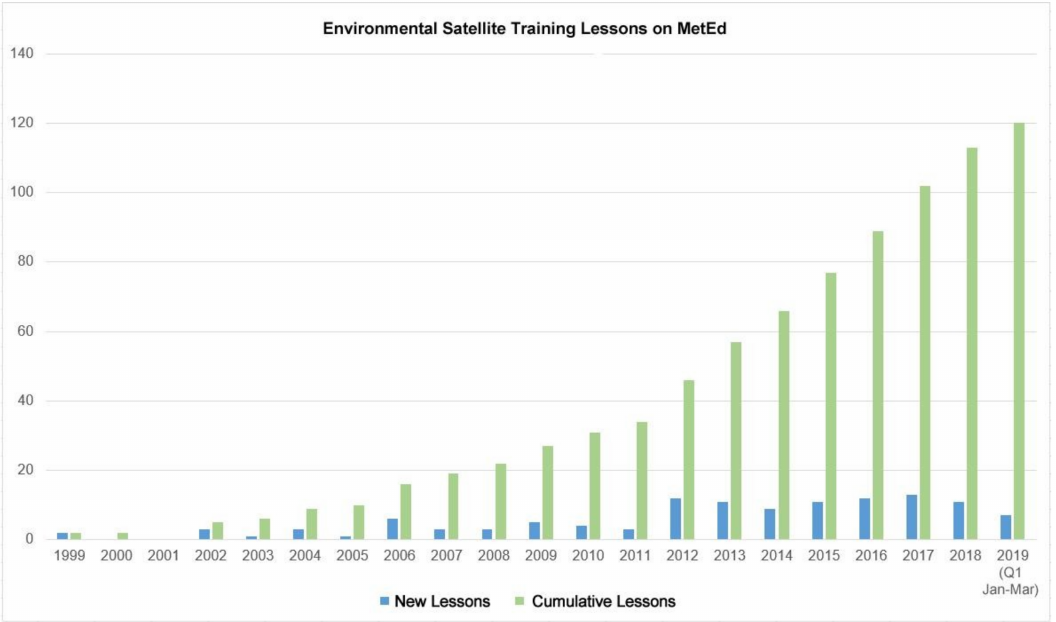
Figure 11. New satellite meteorology lessons published per year (blue) and cumulative number of satellite meteorology lessons (green) on MetEd from 1999 to March 2019. As of early April 2019, COMET o ff ers approximately 120 satellite meteorology lessons on